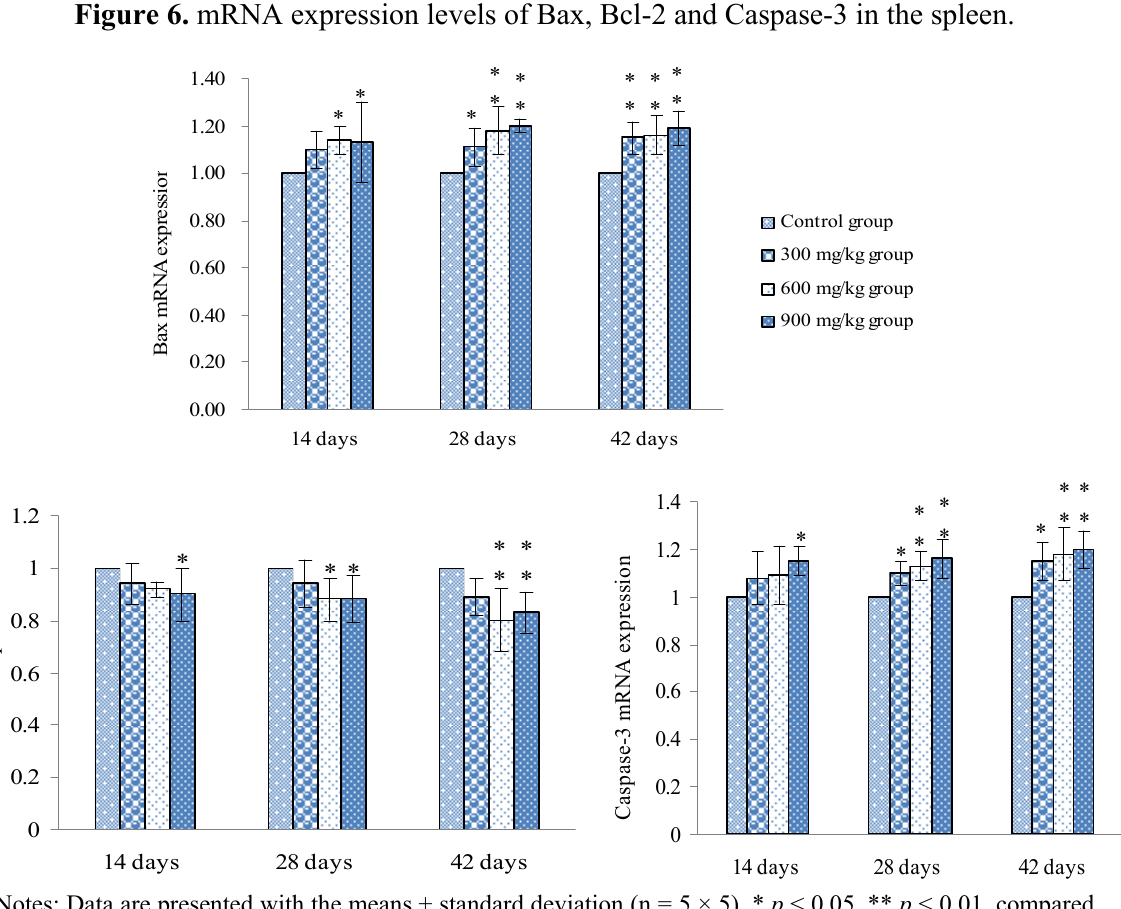
Figure 6. mRNA expression levels of Bax, Bcl-2 and Caspase-3 in the